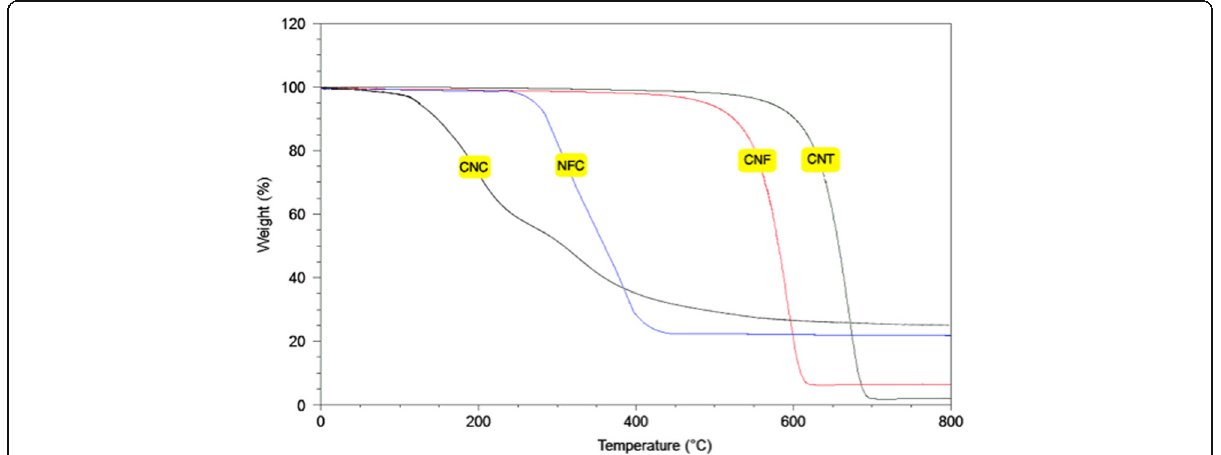
Fig. 3 TGA curves of CNC, NFC, CNF, and